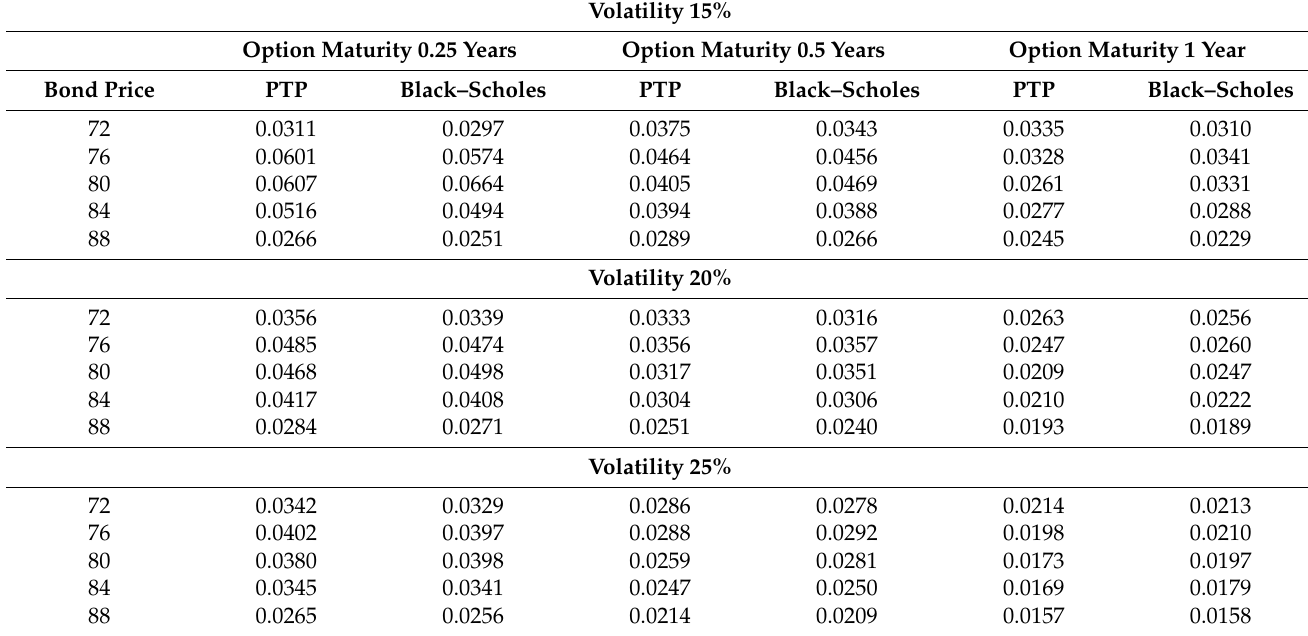
Table 4 presents the gamma values with the same underlying data used for the values and deltas. Table 4. Comparison of PTP gammas to Black–Scholes: strike price 80, risk-free rate 0.5%, bond maturity 20 years.